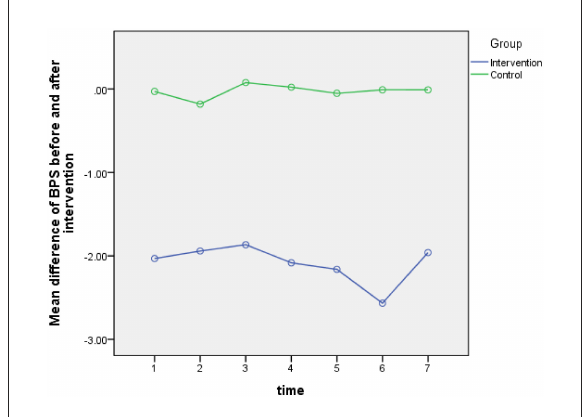
FIGURE3 The BPS score changes in the study groups in seen time